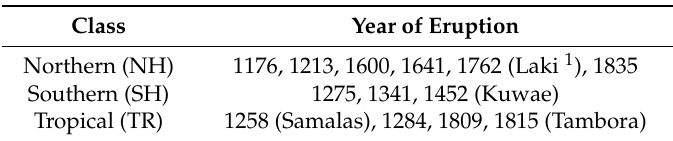
Table 1. List of volcanic eruptions selected for this